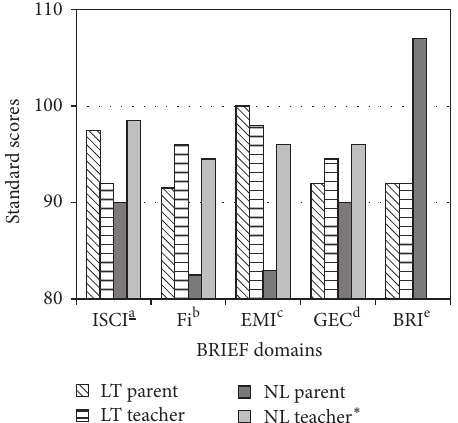
Figure 4: BRIEF parent and teacher scores between LT and NL group. ∗ Higher scores represent poorer perceived functioning. a Inhibitory Self-Control Index. b Flexibility Index. c Emergent Meta- cognition Index. d Global executive composite. e Behavioural Regu- lation